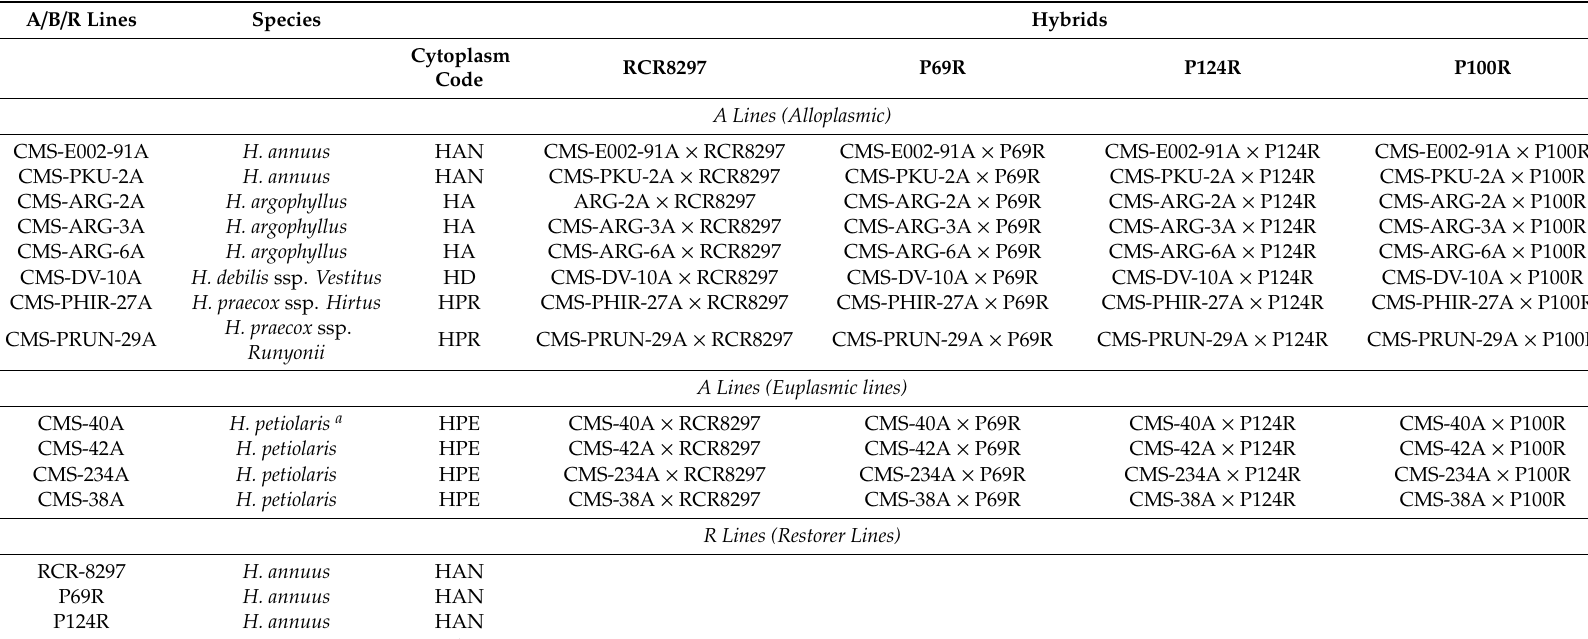
Table 9. The list of genotypes and their interspecific hybrids ( n = 48) used in the study as adapted from Tyagi et al.